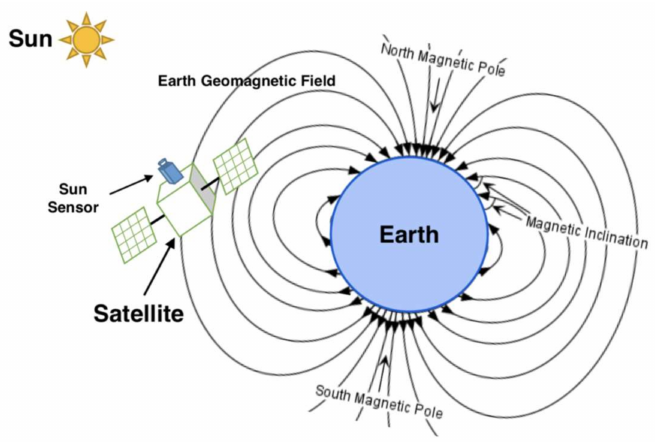
Figure 1. The vector observations-based attitude determination in astronautical application (permis- sion granted from